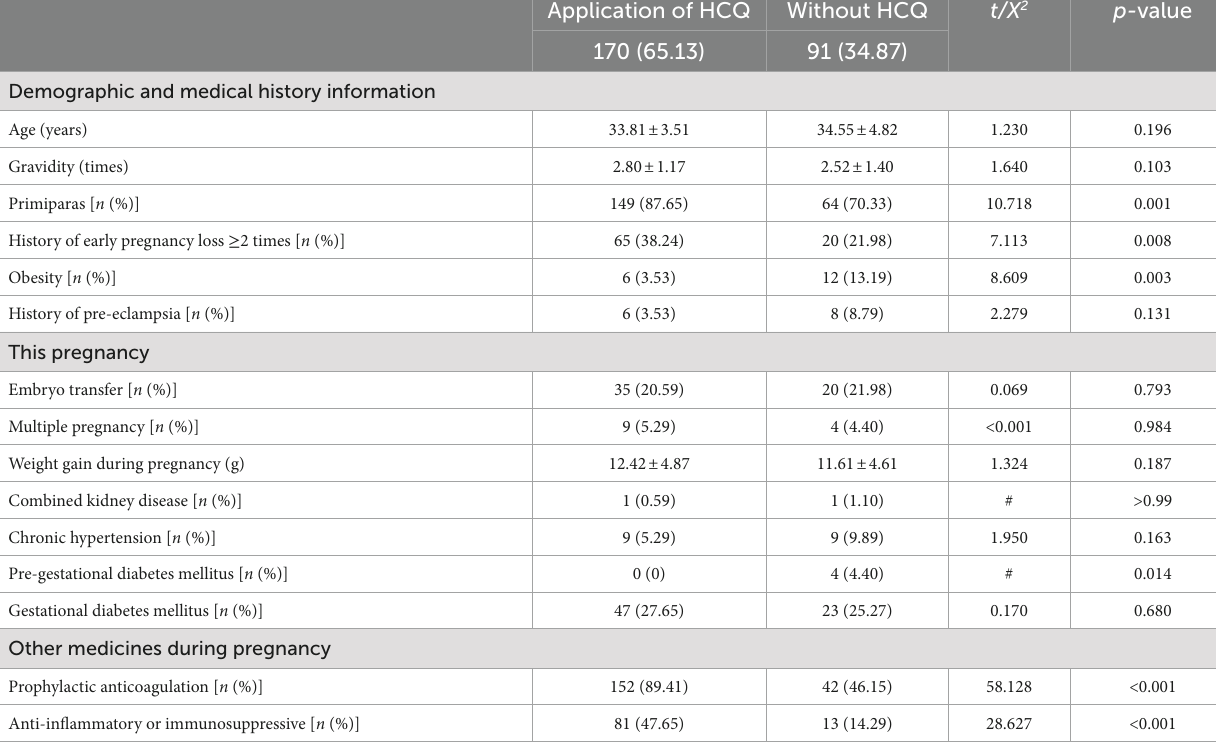
TABLE 1 Demographic information and clinical characteristics of antinuclear antibody spectrum-positive population. Application of